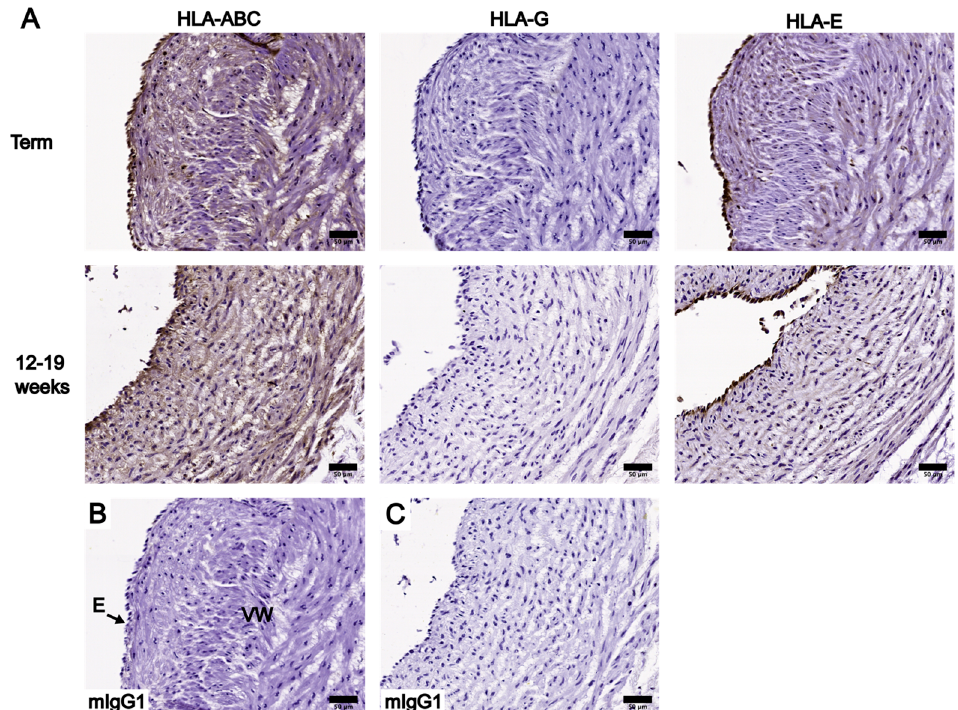
Figure 6. Comparison of IHC staining results of HLA-ABC, HLA-G, and HLA-E in whole UC cross- sections at term and between 12 and 19 weeks, focusing on one of the umbilical vessels. ( A ) IHC staining results of term UC are shown in the first row, and IHC staining results of UC between 12 and 19 weeks are shown in the second row. ( B ) Negative control of term UC IHC staining results using an anti-mIgG1 antibody. ( C ) Negative control of 12–19-week UC IHC staining results using an ant-mIgG1 antibody. Scale bars = 50 µm.